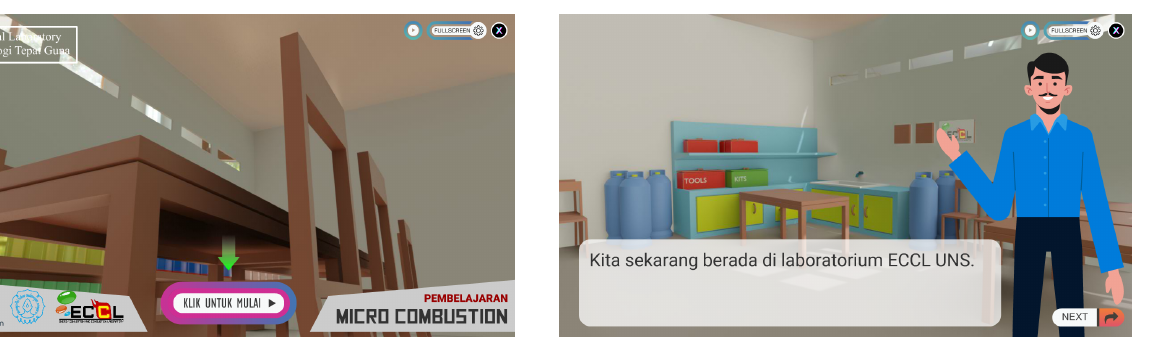
Figure 6: Machine laboratory